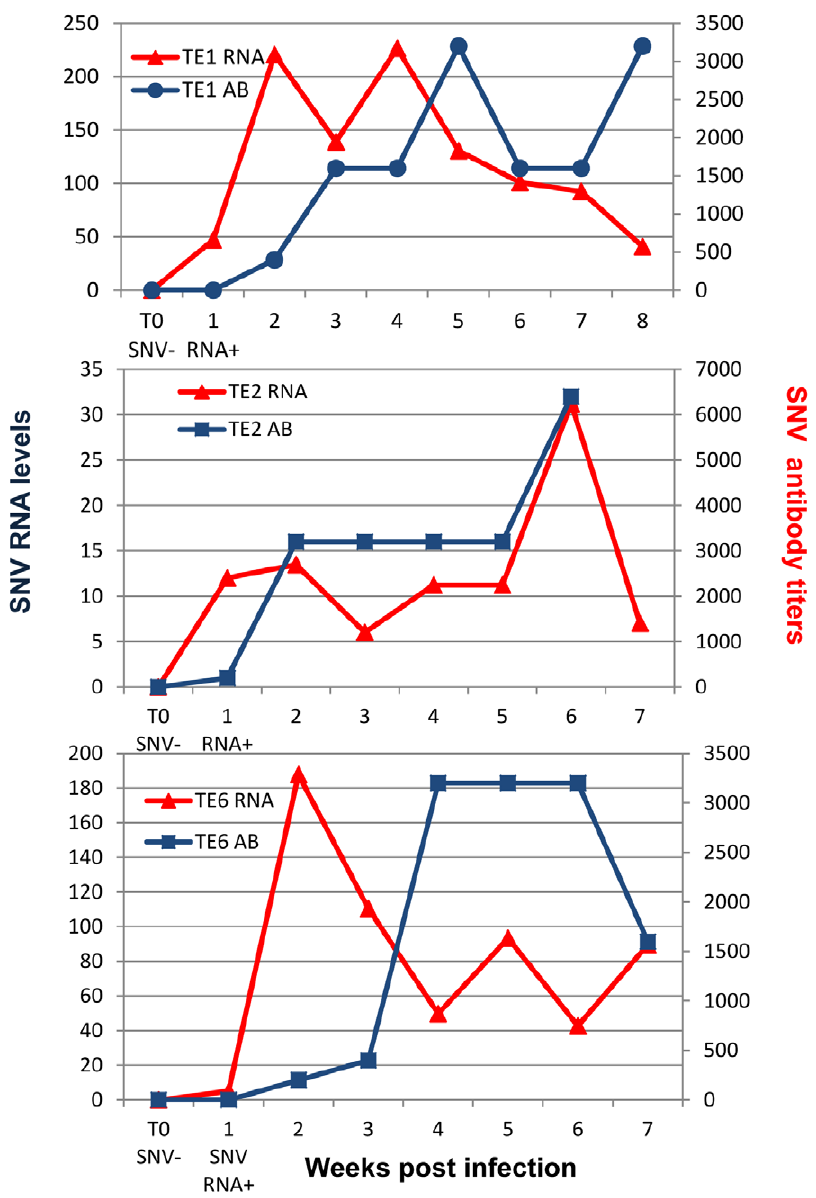
Figure 3. SNV RNA levels and SNV antibody titers for TE deermice with the longest time course of infection. T0 represents the last blood sample negative for both SNV RNA and SNV antibody before SNV RNA or antibody was detected.